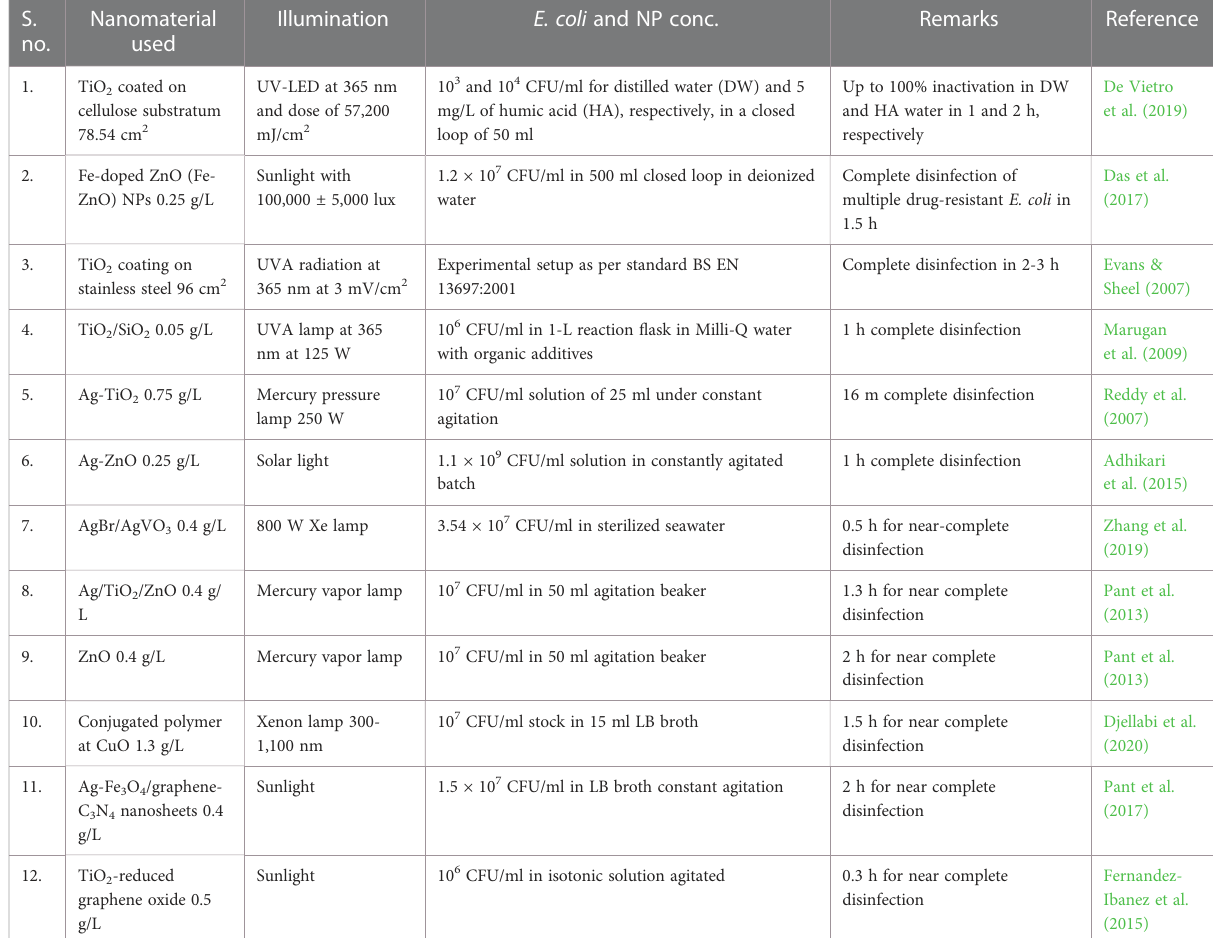
TABLE 1 Nanophotocatalysts used to disinfect Escherichia coli contamination from water.